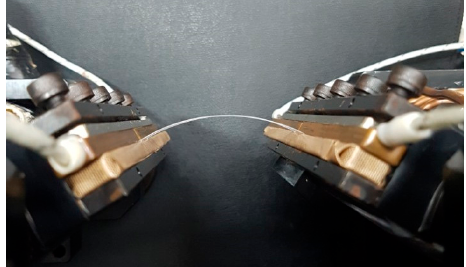
Figure 8. Deformed specimen in an arc shape.